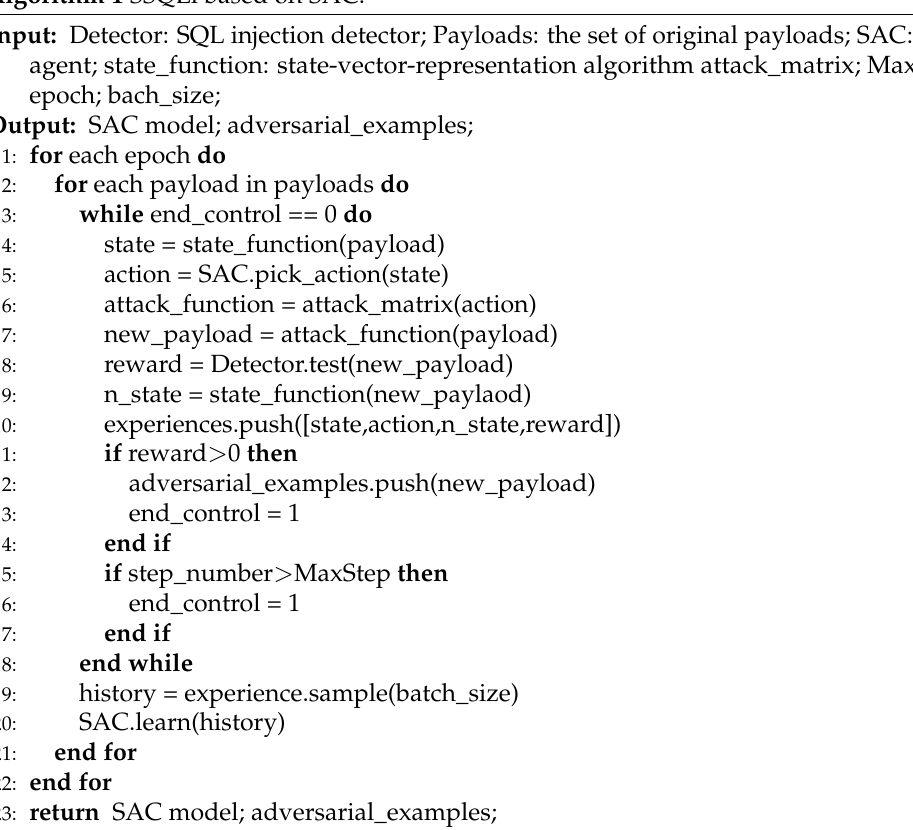
Algorithm 1 SSQLi based on